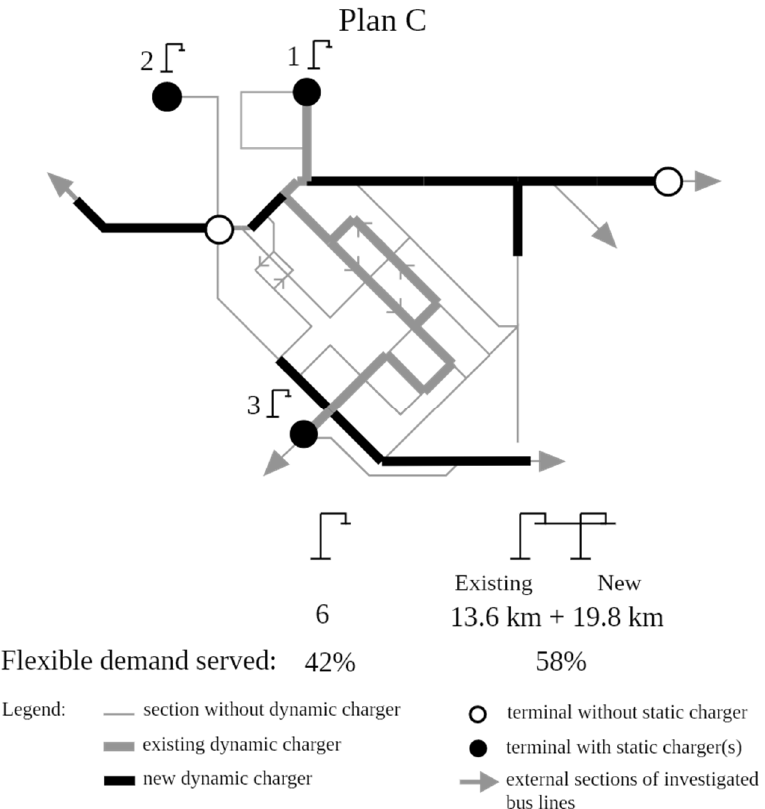
Figure 8. Optimum charging infrastructure plan in the case of existing charging infrastructure.